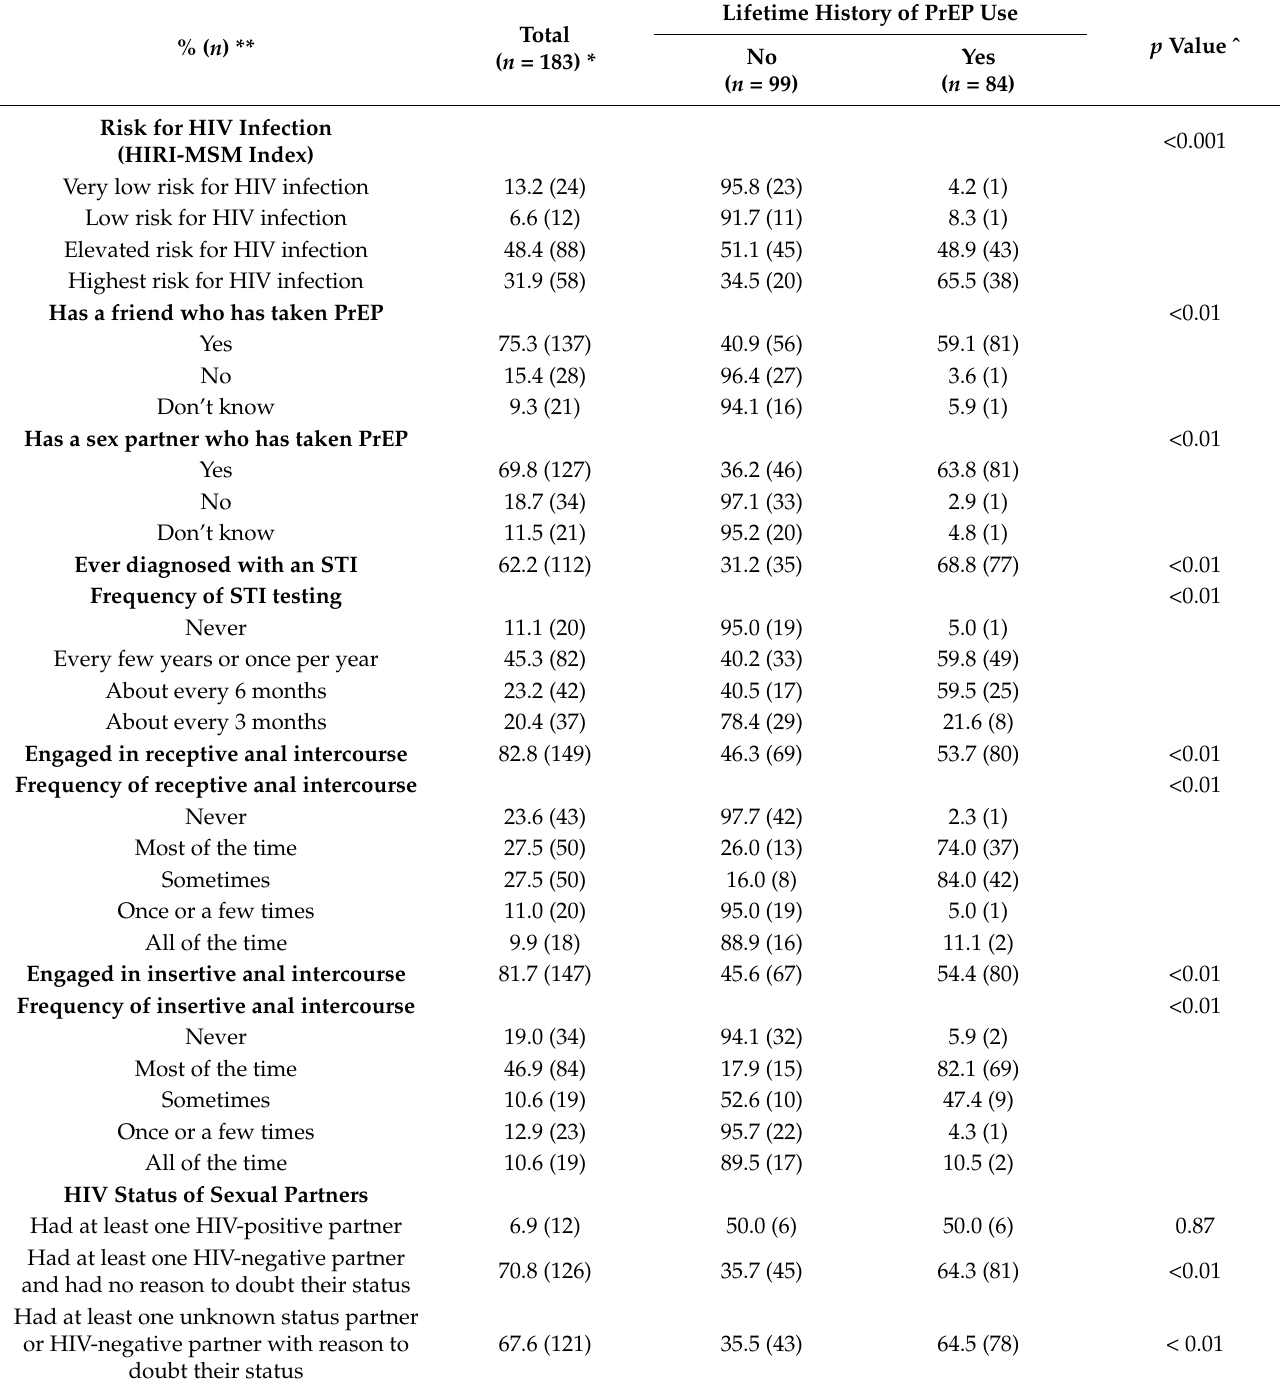
Table 2. Behavioral characteristics of a community-based sample of cisgender men and transgender women who have sex with men residing on Long Island, stratified by lifetime history of pre-exposure prophylaxis (PrEP) use,